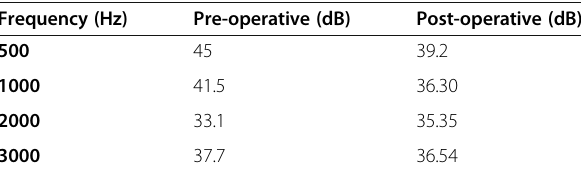
Table 4 Frequency wise average pre-op and post-operative ACT in dB ( n =42)